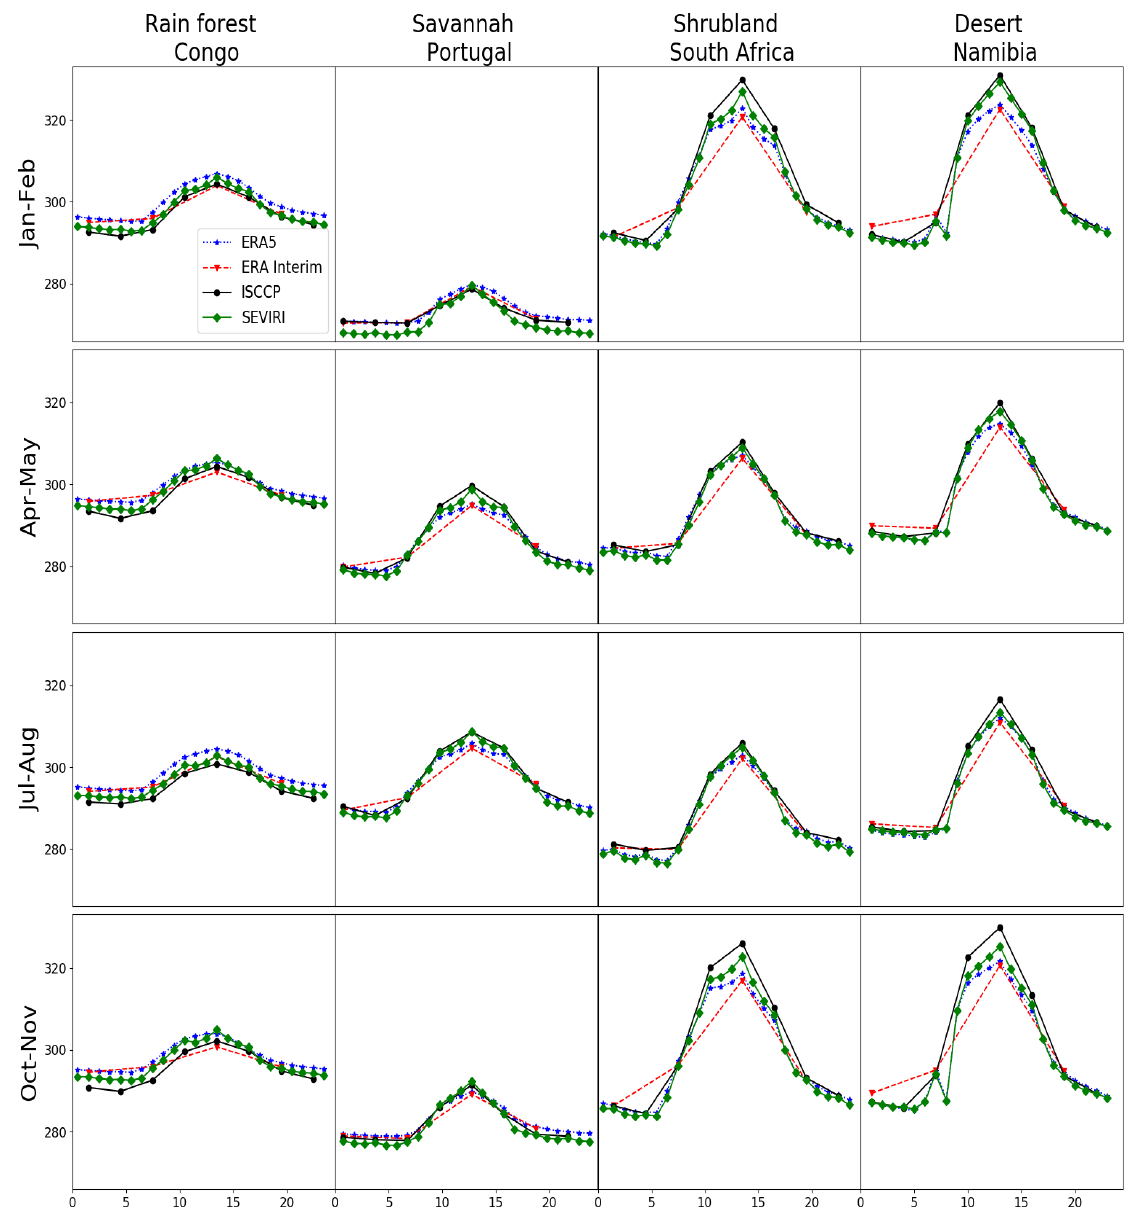
Figure 3. Diurnal LST variations (unit: K) for ERA5, ERA Interim, ISCCP, and SEVIRI over four selected vegetation types in January–February, April–May, July–August, and October–November in 2010. X -axis represents local time. The columns represent four selected regions, and the rows for the four